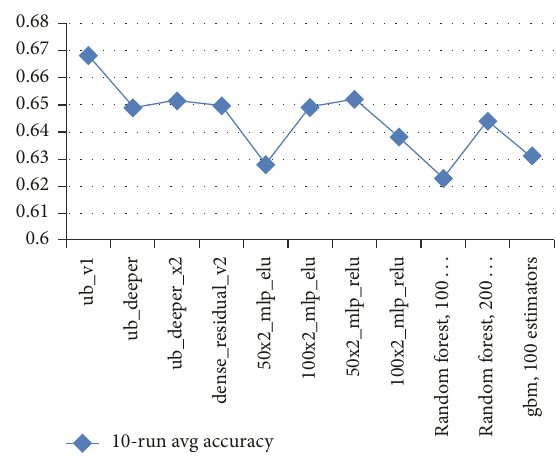
Figure 5: 10-run average